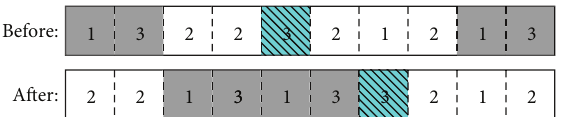
Figure 4: An individual with ten aircrafts before and after LSI local